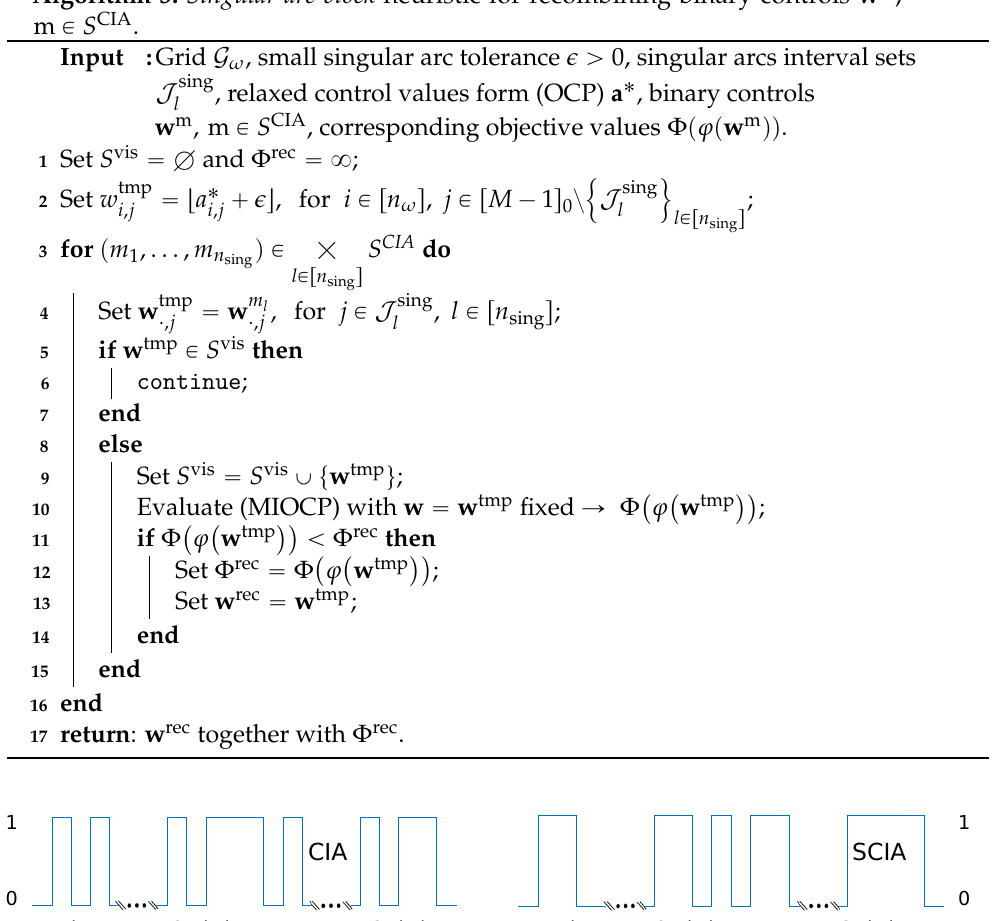
Algorithm 3: Singular arc block heuristic for recombining binary controls w m ,